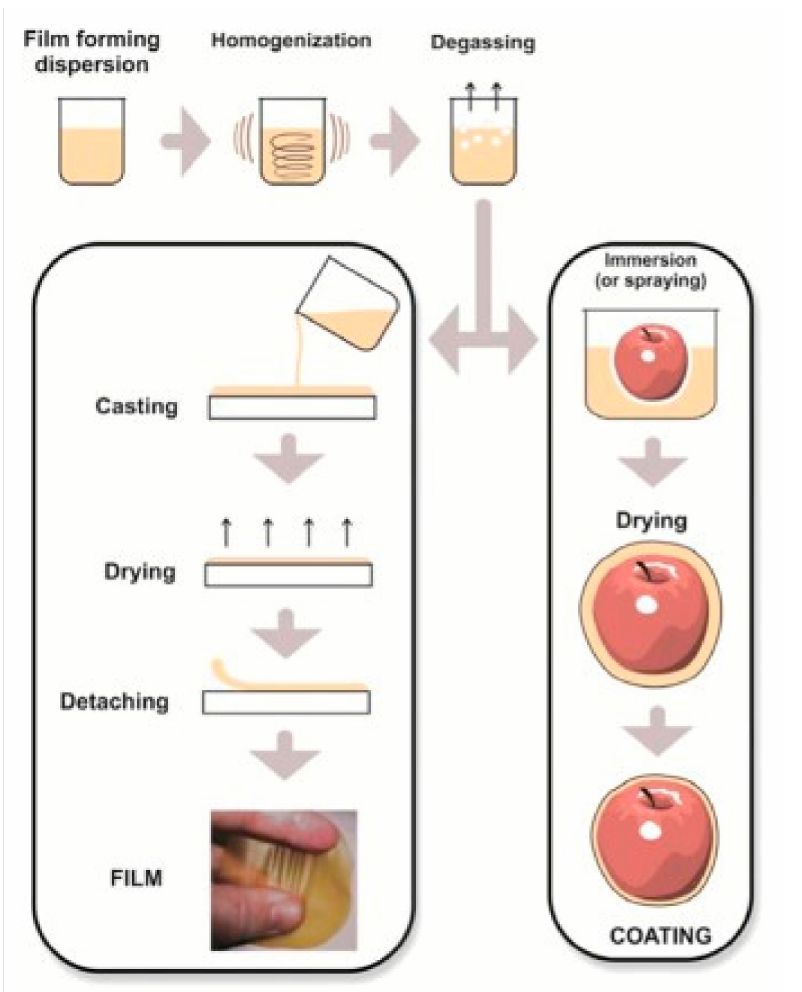
Figure 1. A graphical representation of the development of the films and application